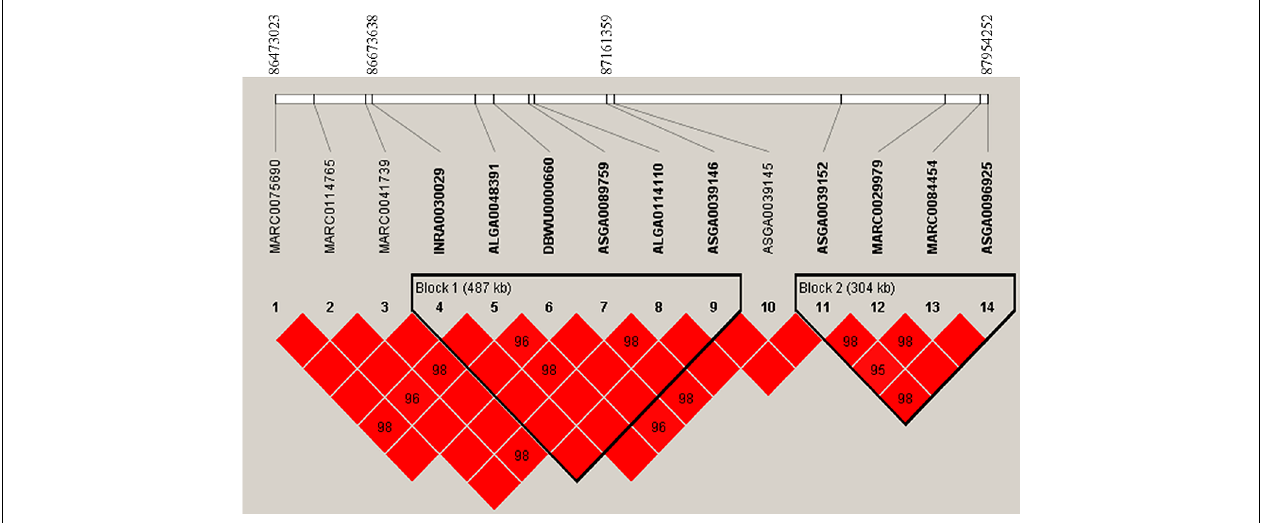
FIGURE 3 | Linkage disequilibrium (LD) pattern on a region from 86 to 88 Mb on pig chromosome 8. LD blocks are marked with triangles.Values in boxes are LD ( r 2 ) between SNP pairs and the boxes are red indicated LOD > 2 and D (cid:5) = 1 (LOD is the log of the likelihood odds ratio, a measure of confidence in the value of D (cid:5)